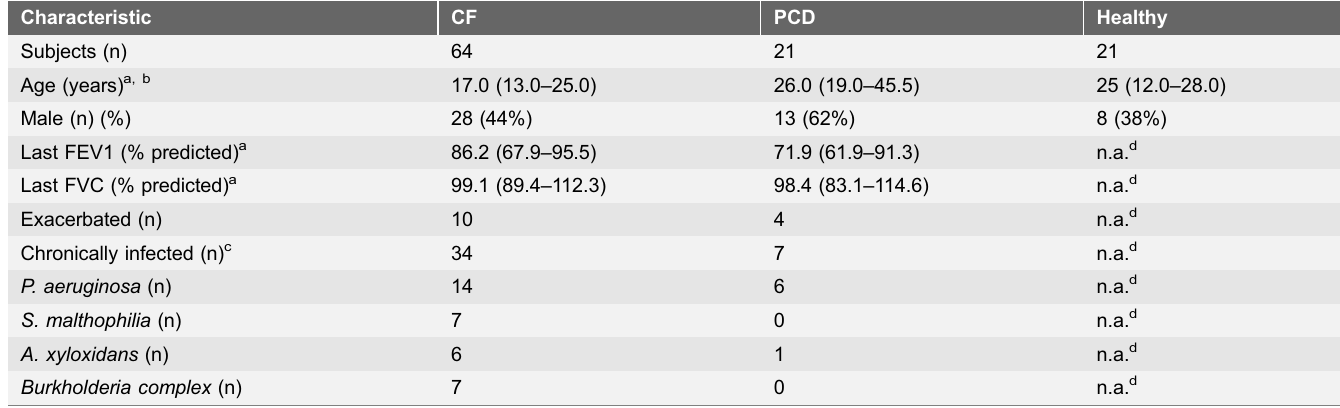
Table 1. Patient